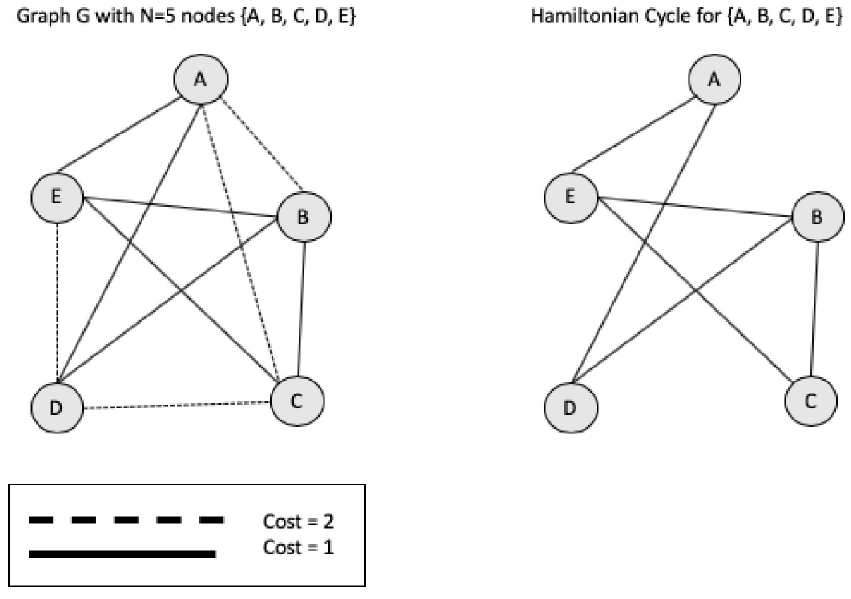
Fig 5. Hamiltonian cycle from a super